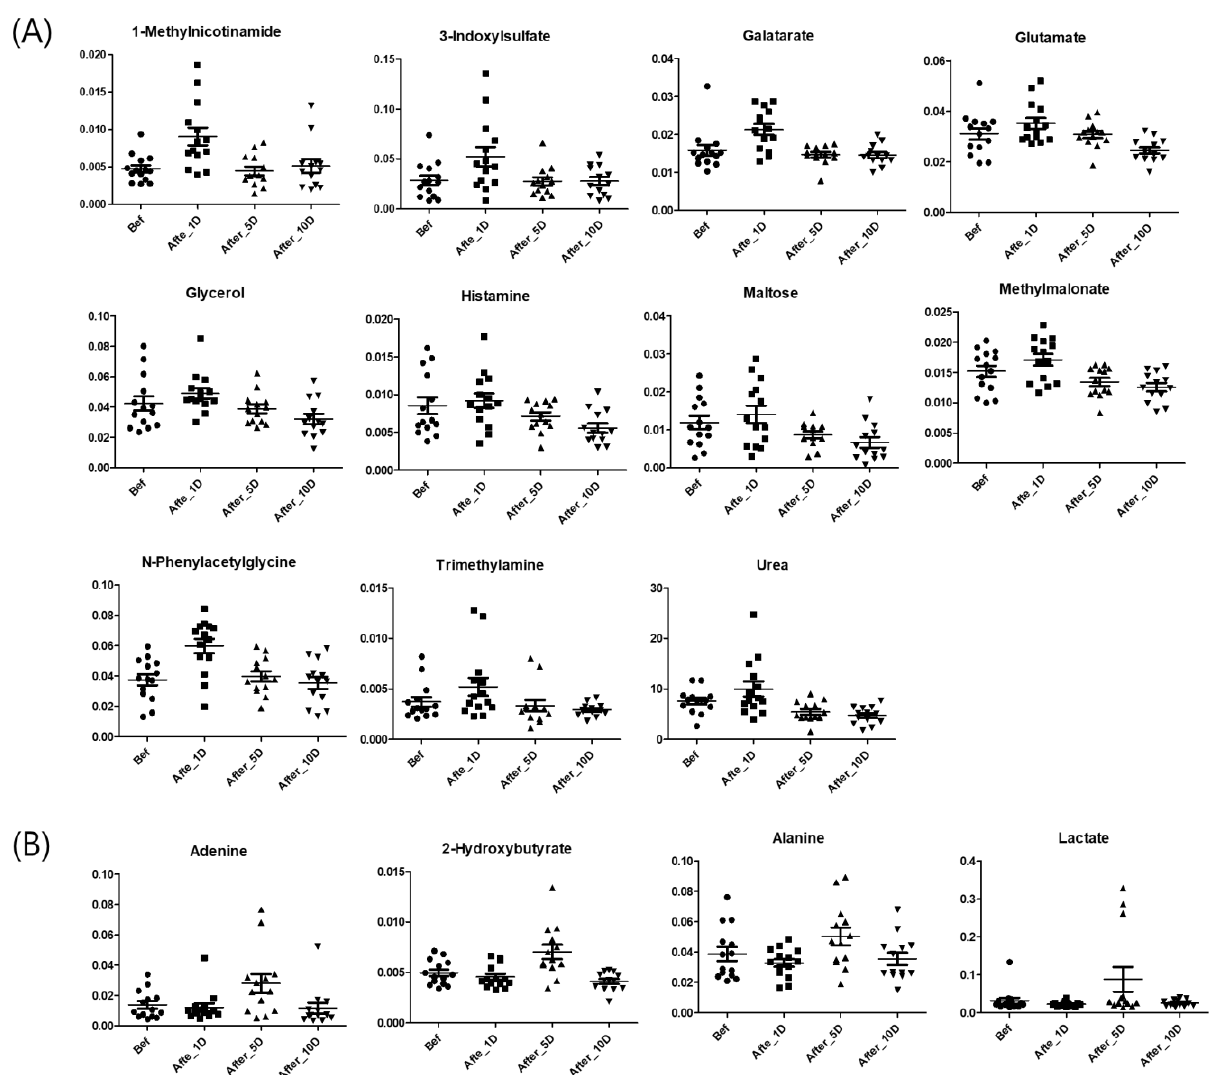
Figure 2. Dot plots of selected metabolites increased 1 day ( A ) and 5 days ( B ) after WTS. Bef: before WTS; Afte_1D: 1 day after WTS; After_5D: 5 days after WTS; After_10D: 10 days after WTS.